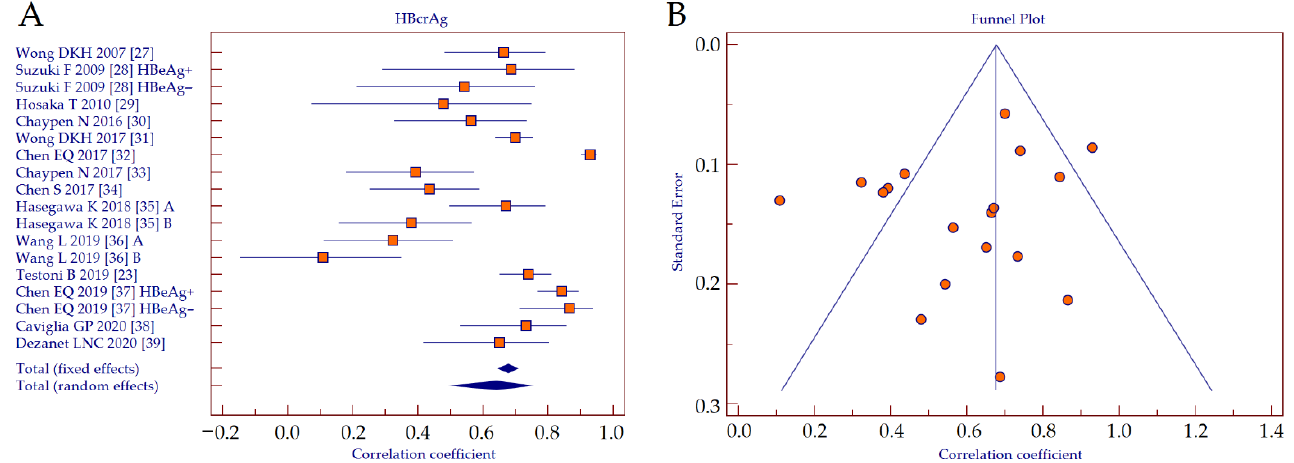
Figure 3. Forest plot ( A ) and funnel plot ( B ) of the correlation between serum HBcrAg and intrahepatic HBV cccDNA. Abbreviations: hepatitis B core-related antigen (HBcrAg), hepatitis B virus (HBV), covalently-closed-circular DNA (cccDNA).